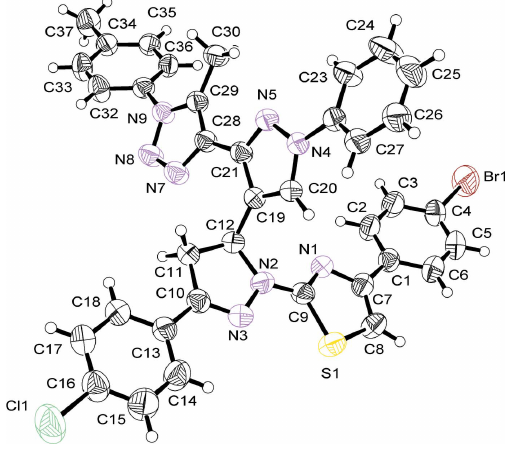
Figure 1 An ORTEP representation of the title molecule showing 50% probability